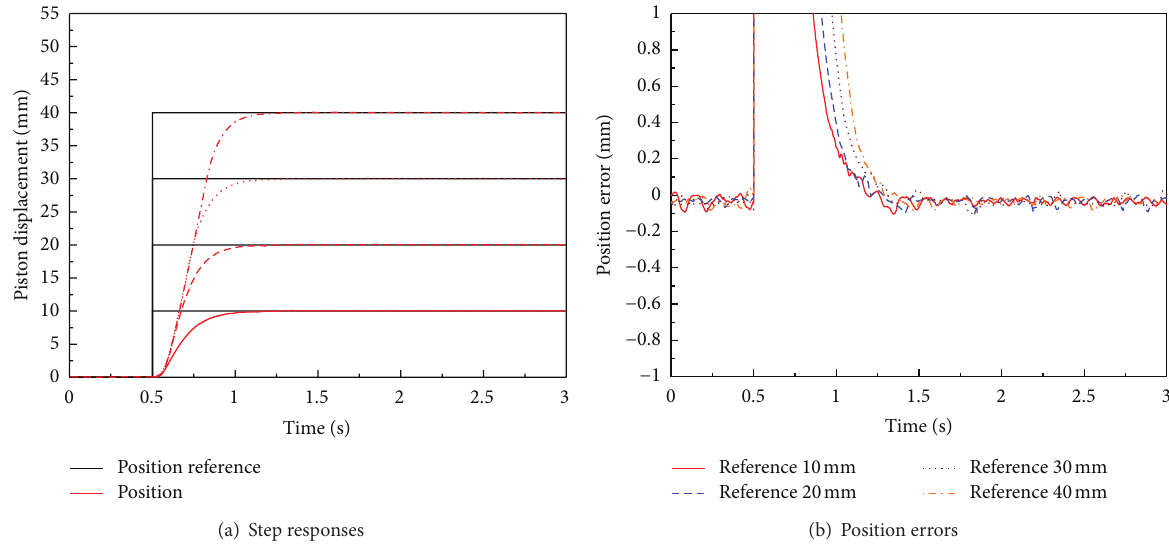
Figure 14: Performances of optimal adaptive antiwindup PID sliding mode position control system for EHA without load disturbance (only mass load is applied).